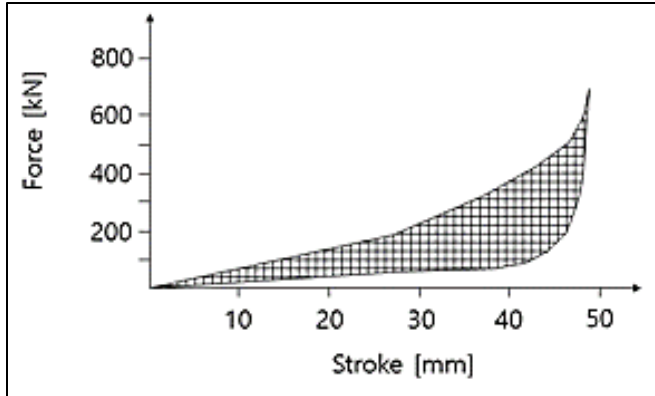
Figure 5. Typical characteristic curve of a rubber buffer [12].